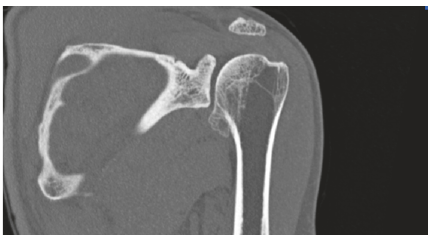
Figure 3: Coronal CT showed an ossified mass in the inferomedial aspect of the proximal humerus epiphysis with no articular or soft tissue involvement. The lesion was very characteristic of DEH and it was classified as extra-articular type B1 (affecting the upper limb, localized to a single bone), according to Clarke’s classification